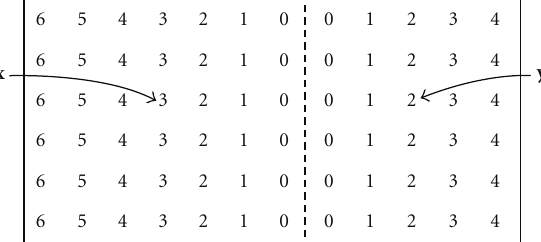
Figure 3: Correctly optimized sphere map of the image in Figure 2. Numbers indicate the integer radius of the sphere at each pixel. Pixels x and y are labeled as